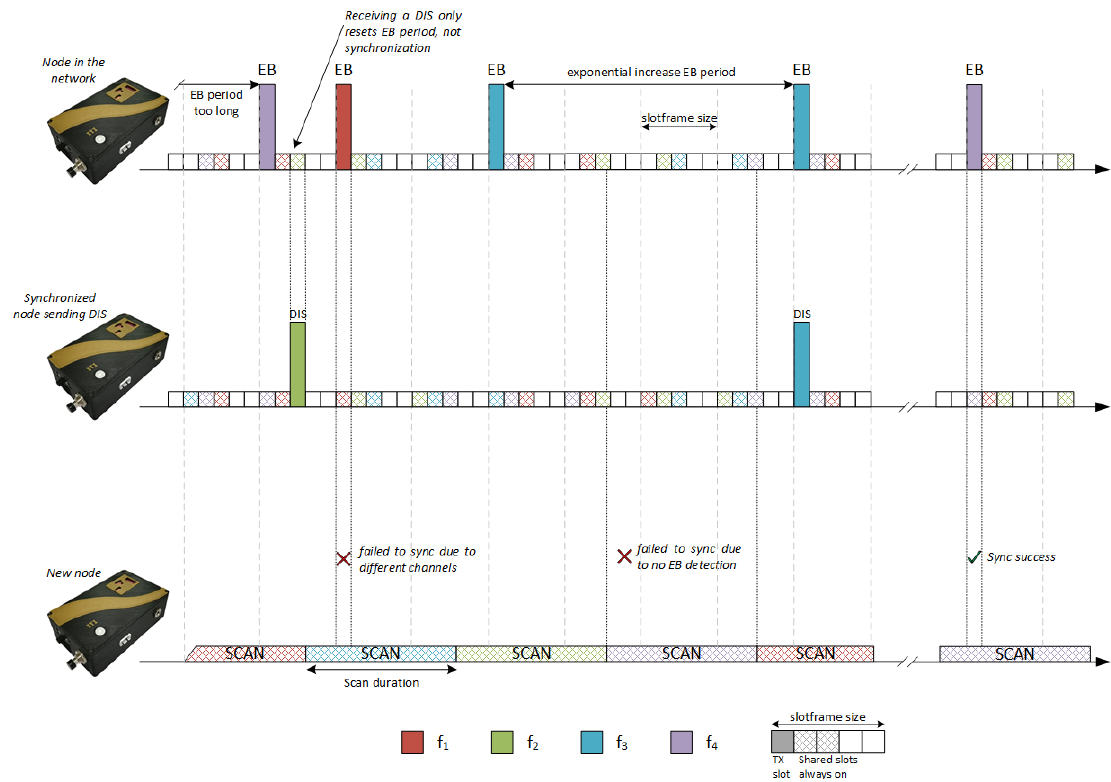
Figure 5. A combination of TSCH and RPL.